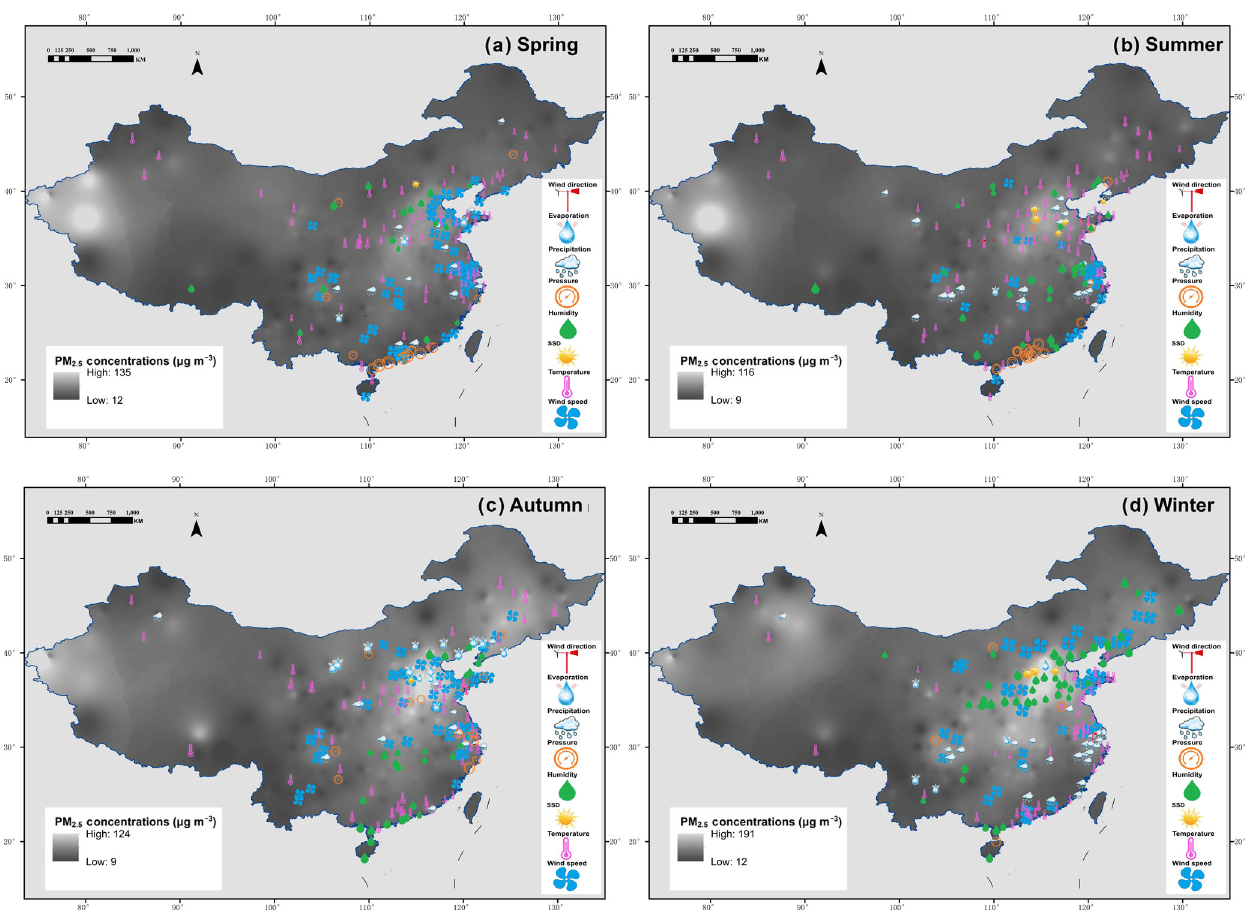
Figure 3. The dominant meteorological factor for local PM 2 . 5 concentrations in 188 monitoring cities across mainland China The size of symbols indicates the ρ value of the meteorological factor on local PM 2 . 5 concentrations.